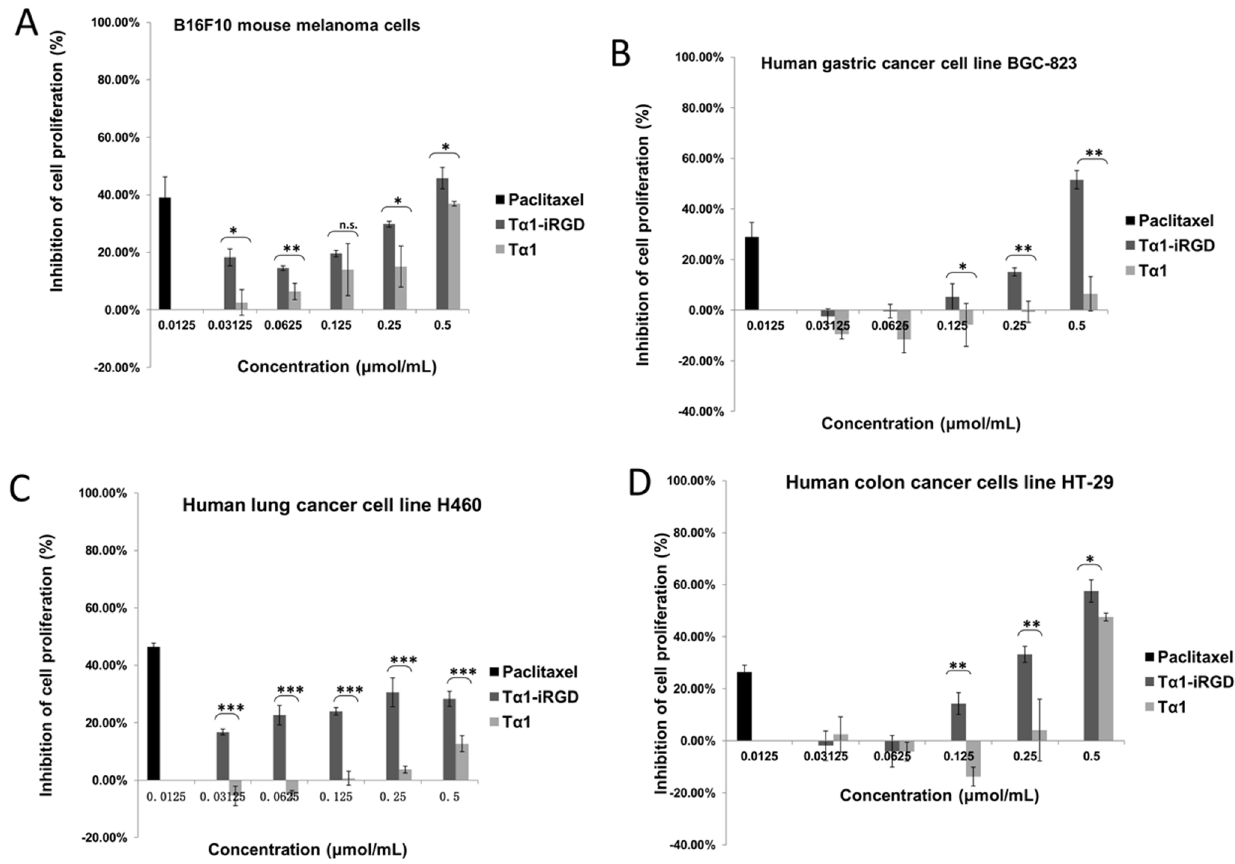
Figure 5. Inhibition of cancer cell proliferation by T a 1 or T a 1-iRGD. T a 1 or T a 1-iRGD was added to the cell suspension and incubated for 36 h and counted by MTT assay. Paclitaxel (0.0125 m mol/mL) was set as a positive control. RPMI 1640 was set as a negative control. All data were expressed as the mean 6 standard deviation, n=4. Statistical analyses were performed with Student’s t-test, n.s., not significant; *p , 0.05; **p , 0.01; ***p , 0.001.